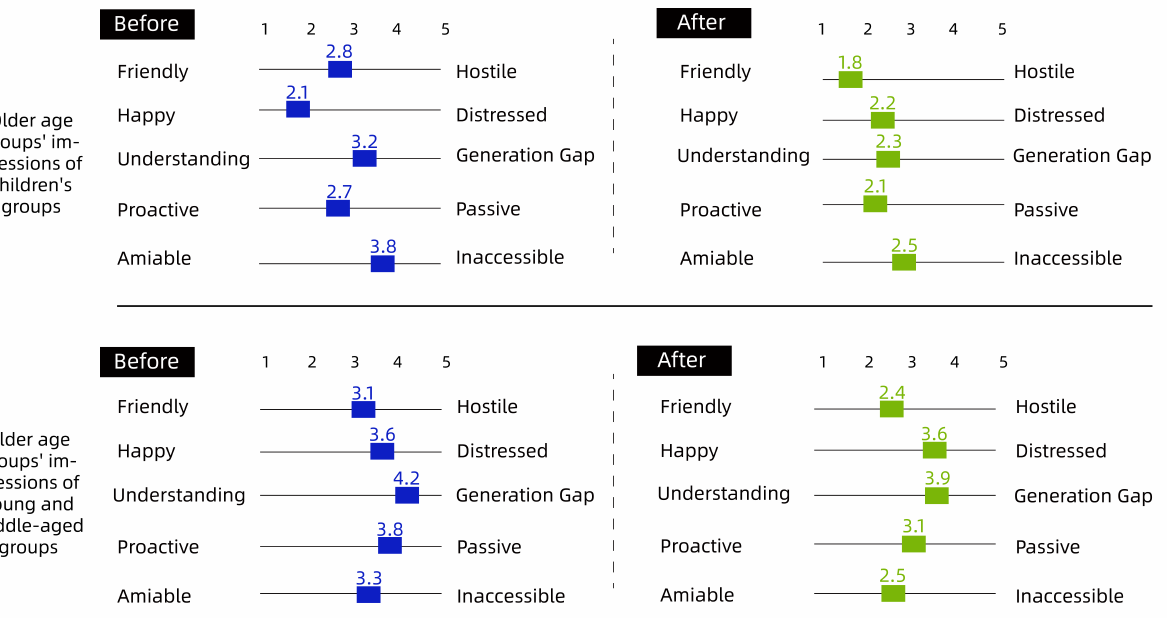
8Figure 8. Old age groups’ impressions of different ages. The change in attitudes of the older age Figure group toward the other groups was not significant.